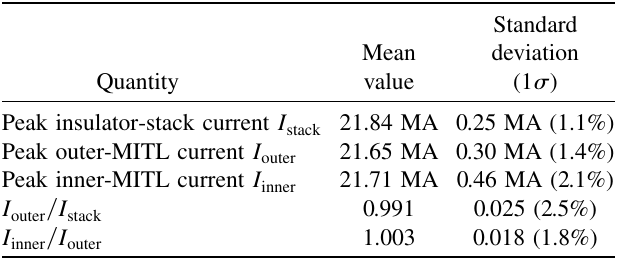
TABLE I. The mean and standard deviation of several mea- sured quantities obtained on eight consecutive nominally iden- tical Z -accelerator [1–9] shots. The load on these shots was a dynamic hohlraum driven by a wire-array z pinch